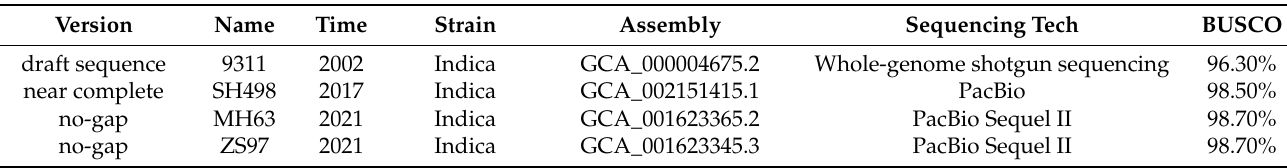
Table 2. Basic information on O. sativa genomic